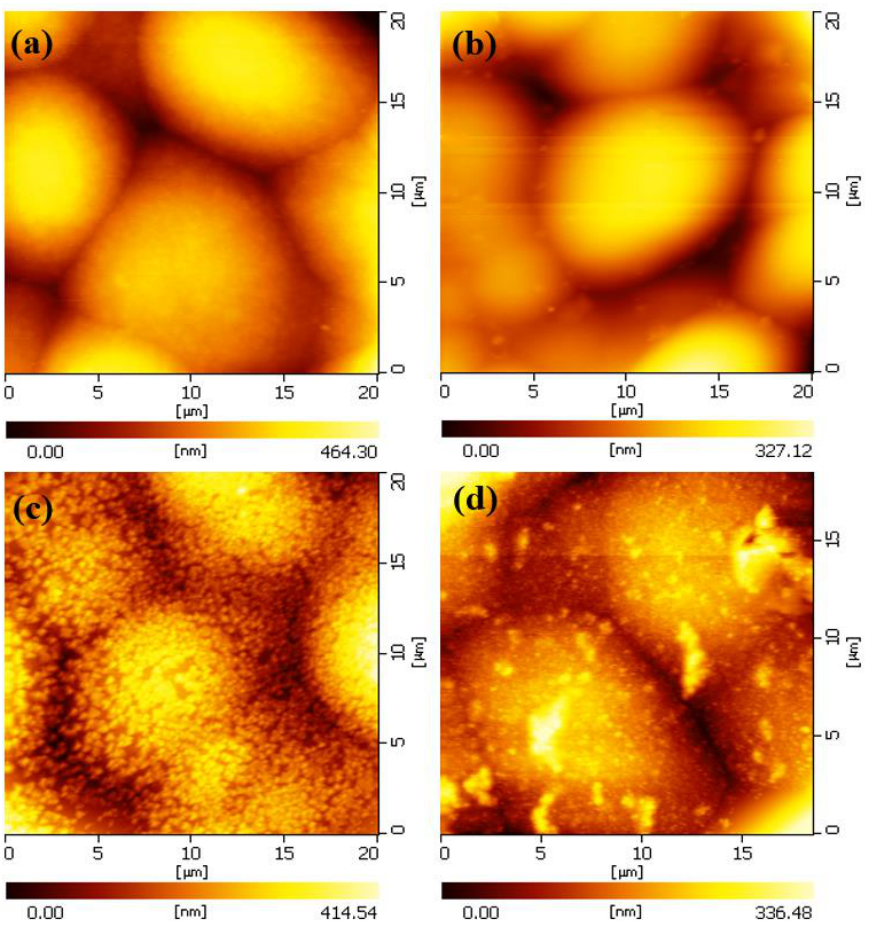
Figure 2. Two-dimensional AFM image of Ni-P coating after heated treatment: ( a ) 200 ◦ C; ( b ) 300 ◦ C; ( c ) 400 ◦ C; ( d ) 500 ◦ C.